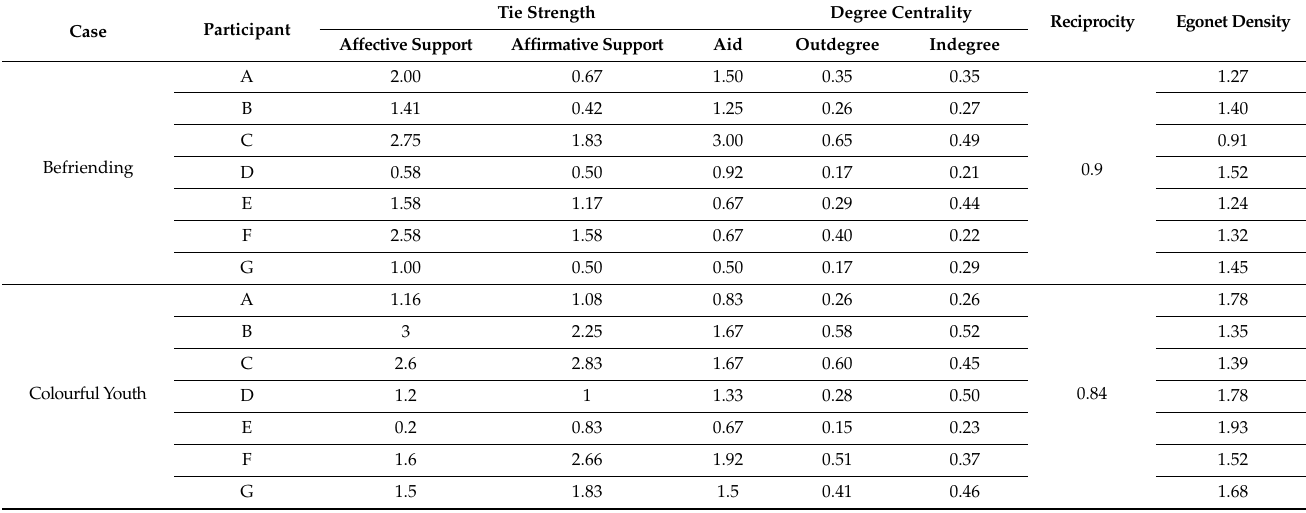
Table A1. Network characteristics of the two